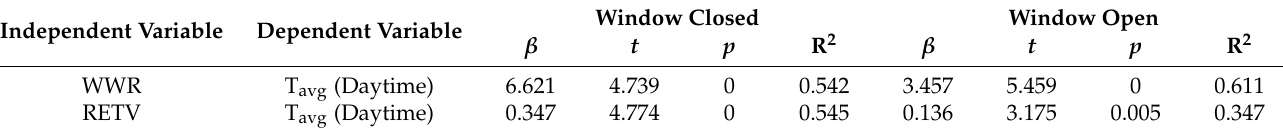
Figure 16. Relationship between RETV and average T a . Table 6. Key indicators of OLS regression analysis.